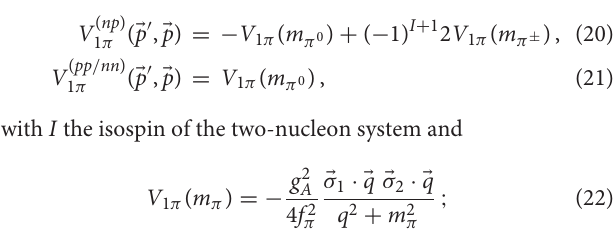
0,1,2,3,4, and 6, respectively. Reprinted figure with permission from Entem et al. =